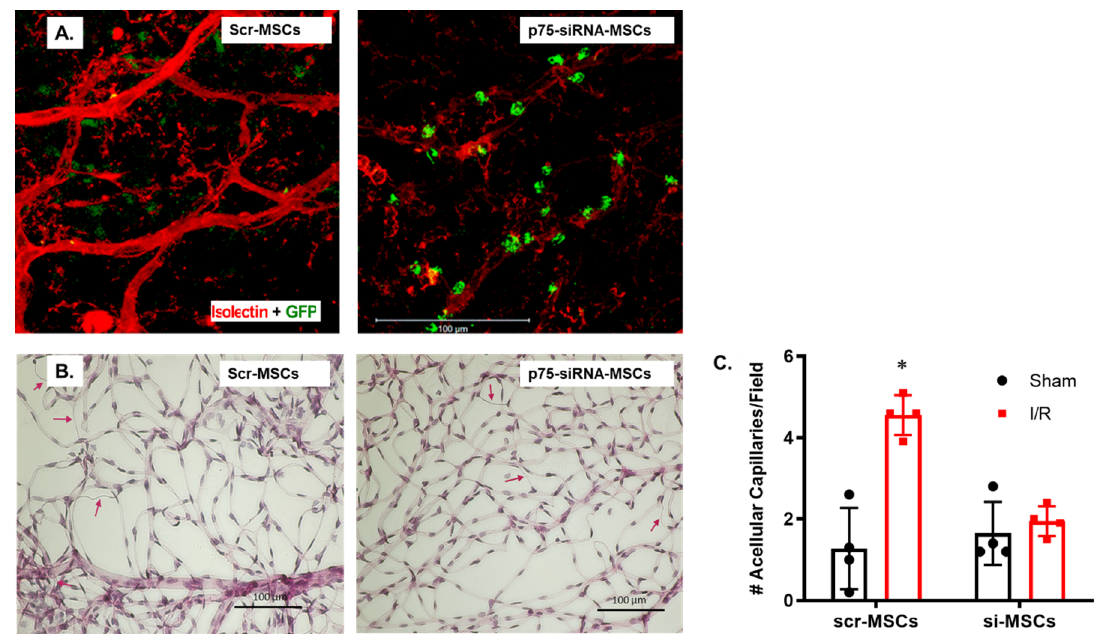
Figure 3. Silencing p75 NTR expression in MSCs increased vascular homing and protection in ischemic retinas. ( A ) Confocal images of ischemic WT retinal flat mounts stained with Isolectin-GS (red), showing numerous GFP-labeled MSCs (green) recruited to retinal capillaries (red) after silencing p75 NTR expression when compared to scrambled-MSCs (40x magnifica- tion). ( B ) Representative trypsin-digested and PASH-stained ischemic WT retinas showing decreased acellular capillaries (red arrows) in ischemic retinas receiving MSCs that do not express p75 NTR (20x magnification). ( C ) Bar graph and statis- tical analysis for acellular capillaries count in ischemic WT retinas receiving Scrambled mRNA-treated or siRNA-treated MSCs against p75 NTR . Number of acellular capillaries was significantly higher in retinas receiving p75 NTR -expressing MSCs but not p75 NTR -knocked down cells (*, significant using two-way ANOVA, n = 4).